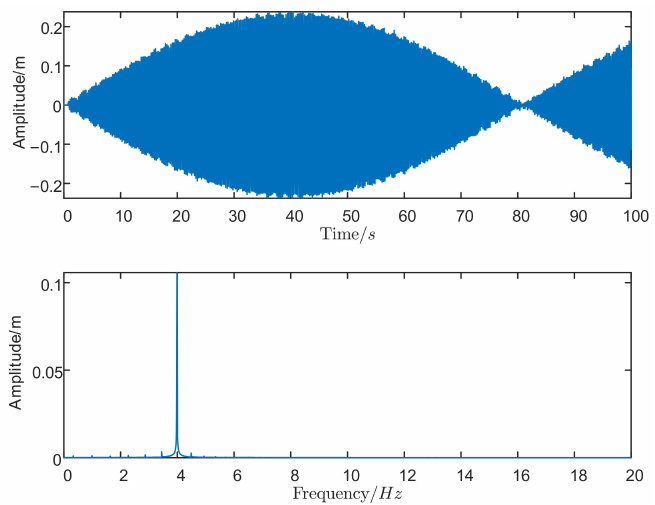
Figure 17. Time histories and FFT result of displacement response.